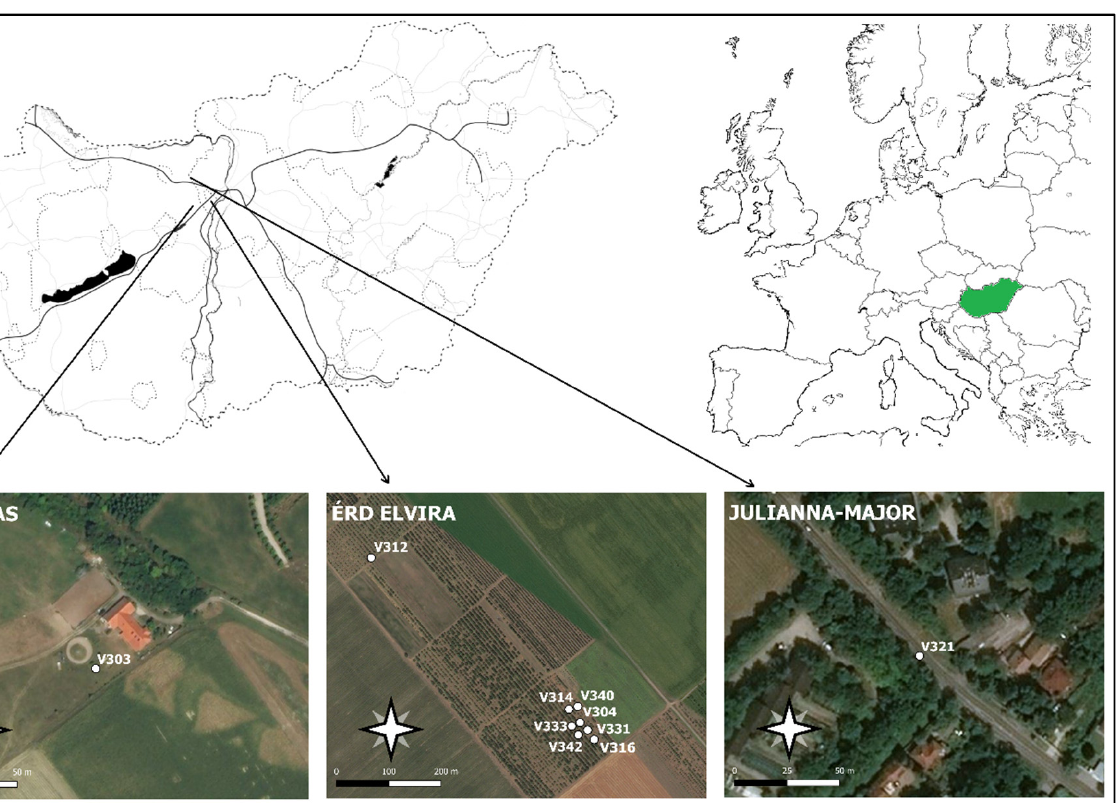
Figure 2. Map of the experimental orchards. White dots indicate the locations of the ZooLog VARL probe prototypes.